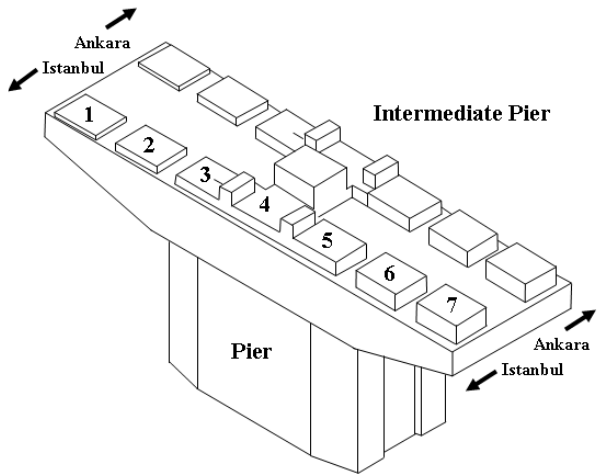
Figure 9: Typical view of viaduct pier.